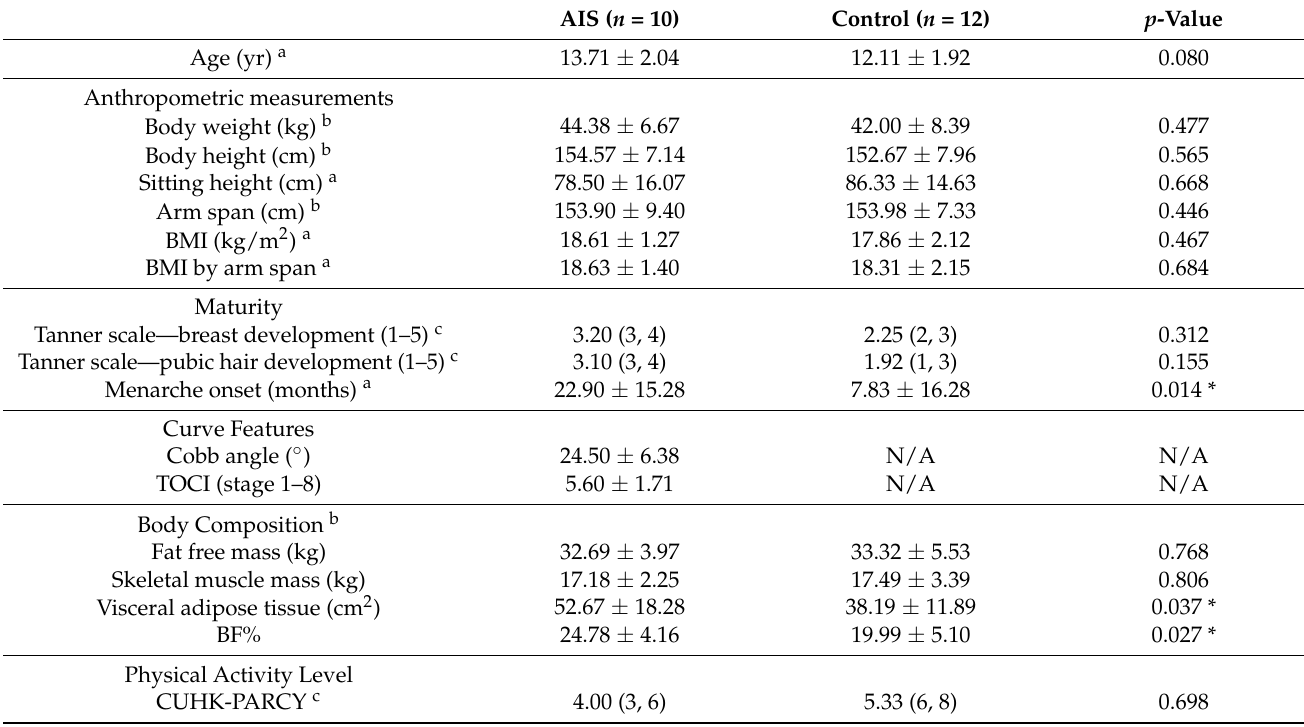
Table 1. Basic characteristics between AIS and control